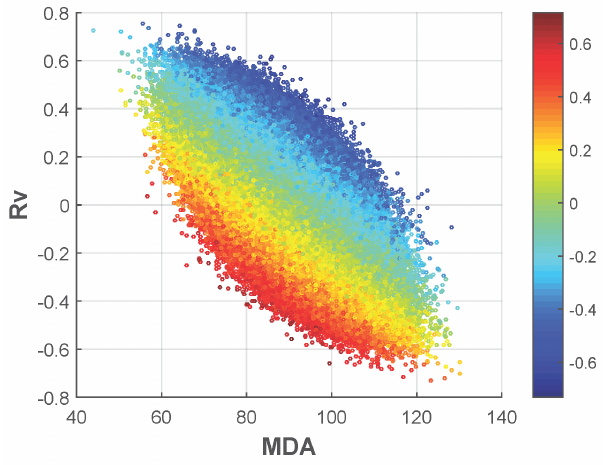
Figure 2. Scatterplot between the vector similarity coefficient ( R v ) and mean difference of angle (MDA) derived from the reference vector field A and randomly generated vector field B . There are 10 6 random vector fields B included in the statistics. The colors denote the correlation coefficients between the vector length and the included angle between two vector